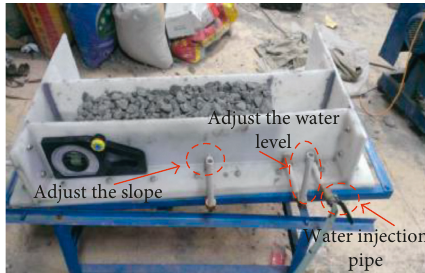
Figure 9: Device diagram of testing water permeability of porous concrete.